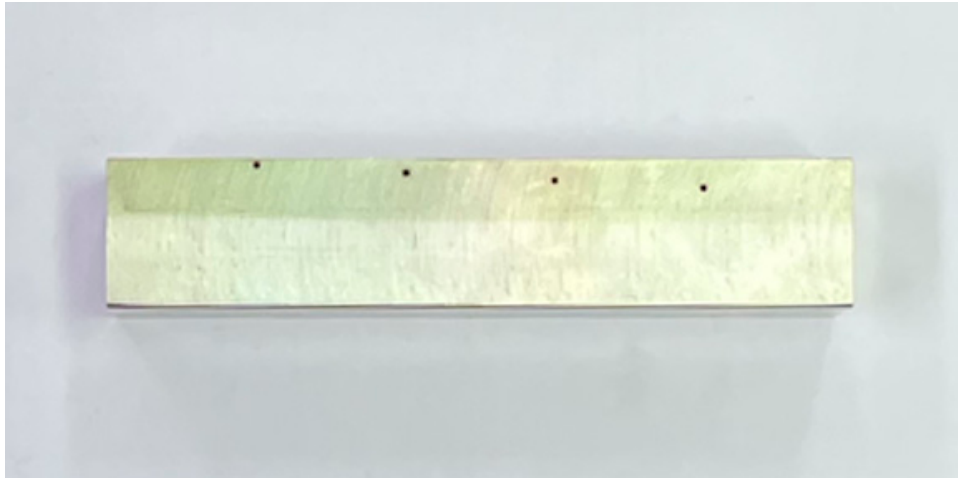
Figure 3. Fabricated standard specimen.